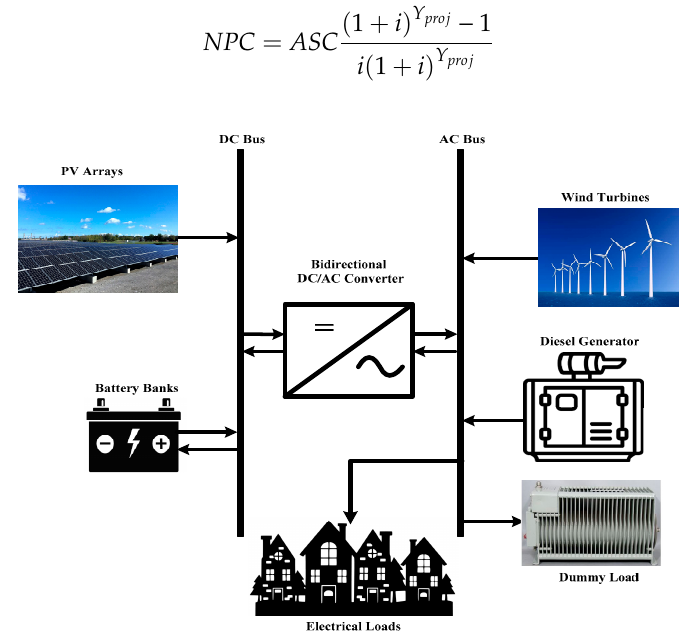
Figure 5. Structure of the proposed hybrid energy system (HES).